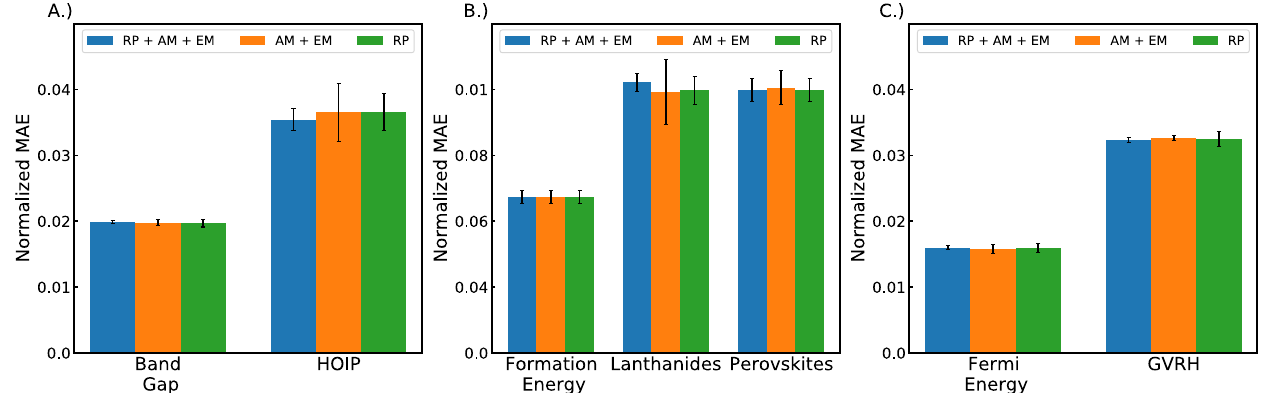
Fig. 2 Ablation study of three augmentation techniques, random perturbation (RP), atom masking (AM), and edge masking (EM), for CT Barlow model. ( A ) Evaluating the effect of different augmentation techniques in Band Gap and HOIP dataset where the label is band gap. ( B ) Evaluating the effect of augmentation techniques on the FE, Lanthanides, and Perovskites datasets for which the label is formation energy. ( C ) VRH - shear modulus of the structures prediction. The Evaluating the effect of different augmentation strategies on the Fermi energy and log 10 error bars indicate variation in MAE over 3 different